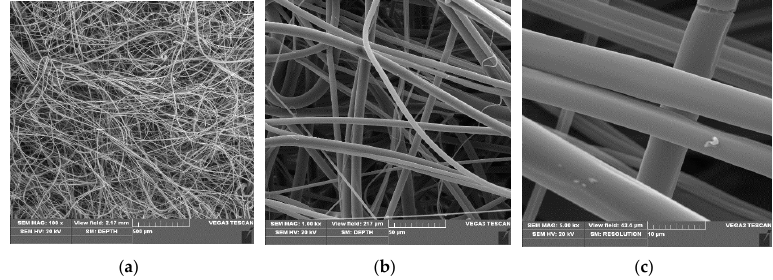
Figure 1. Scanning electron microscopy (SEM) images of poly(lactide) (PLA) non-woven, magnification: ( a ) 100×, ( b ) 1000×, ( c ) 5000×.